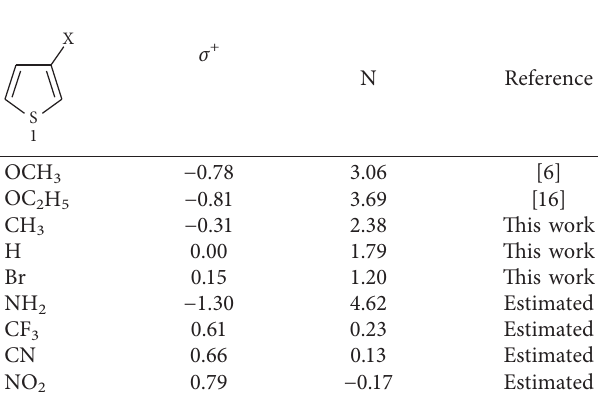
Table 3: Nucleophilicity parameters N of 3-X-substituted thio- phenes in acetonitrile at 20 °